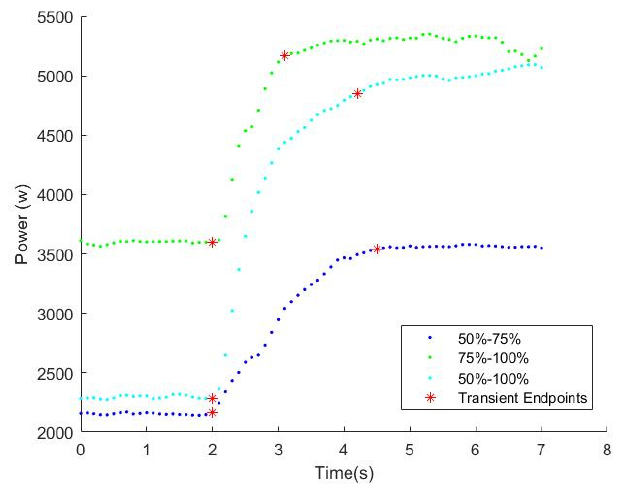
Figure 9. DTC transient power data results.